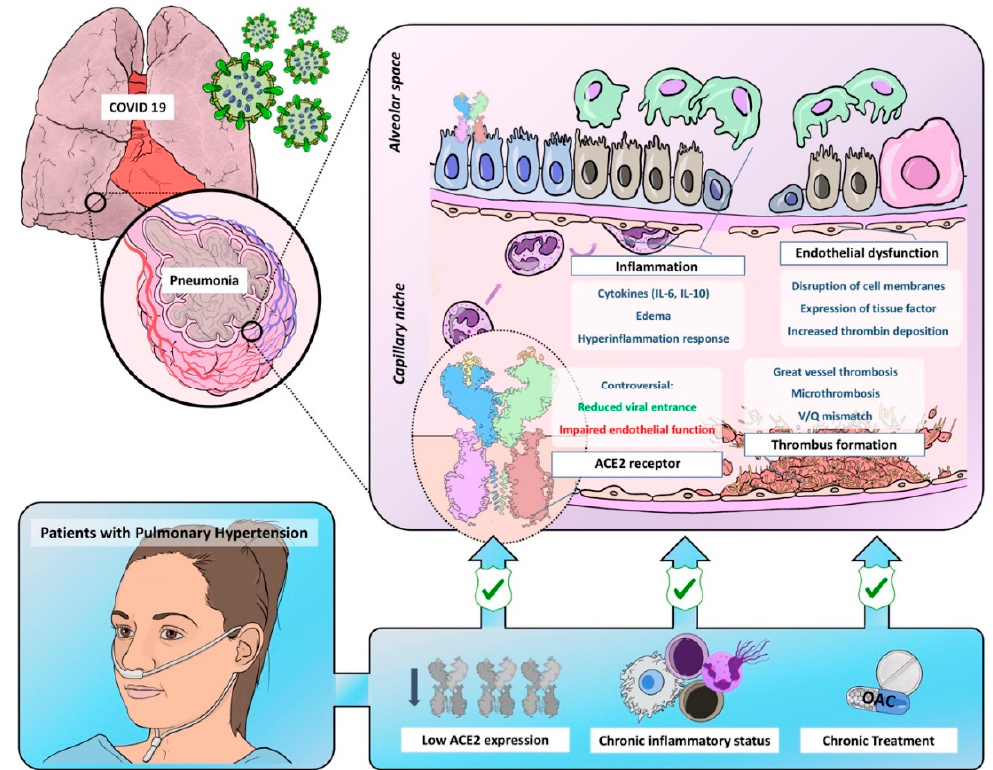
Figure 1. Graphic representation of common pathobiological characteristics between Coronavirus Disease of 2019 and pulmonary hypertension and the possible mechanisms leading to a reduced virulence and severity in this population. ACE2 = angiotensin-converter enzyme 2; OAC = oral anticoagulant.